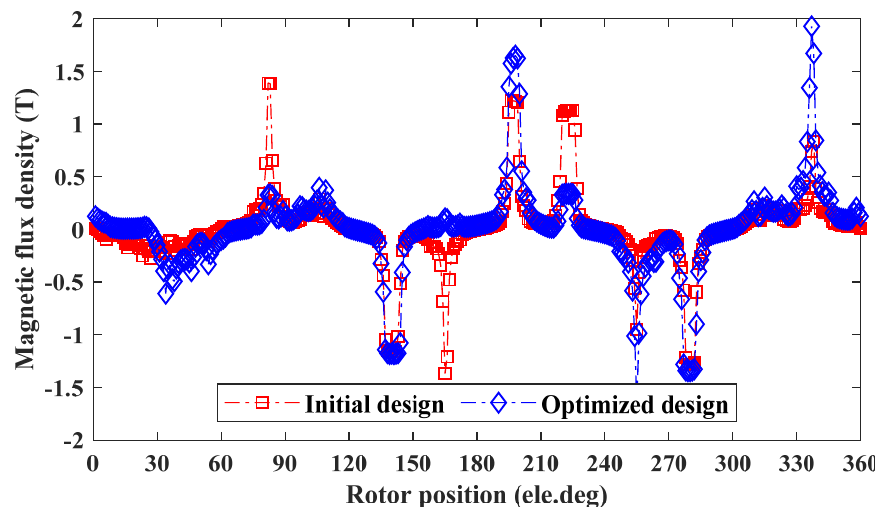
Figure 10. Variation of the magnetic flux density over one periodic cycle.